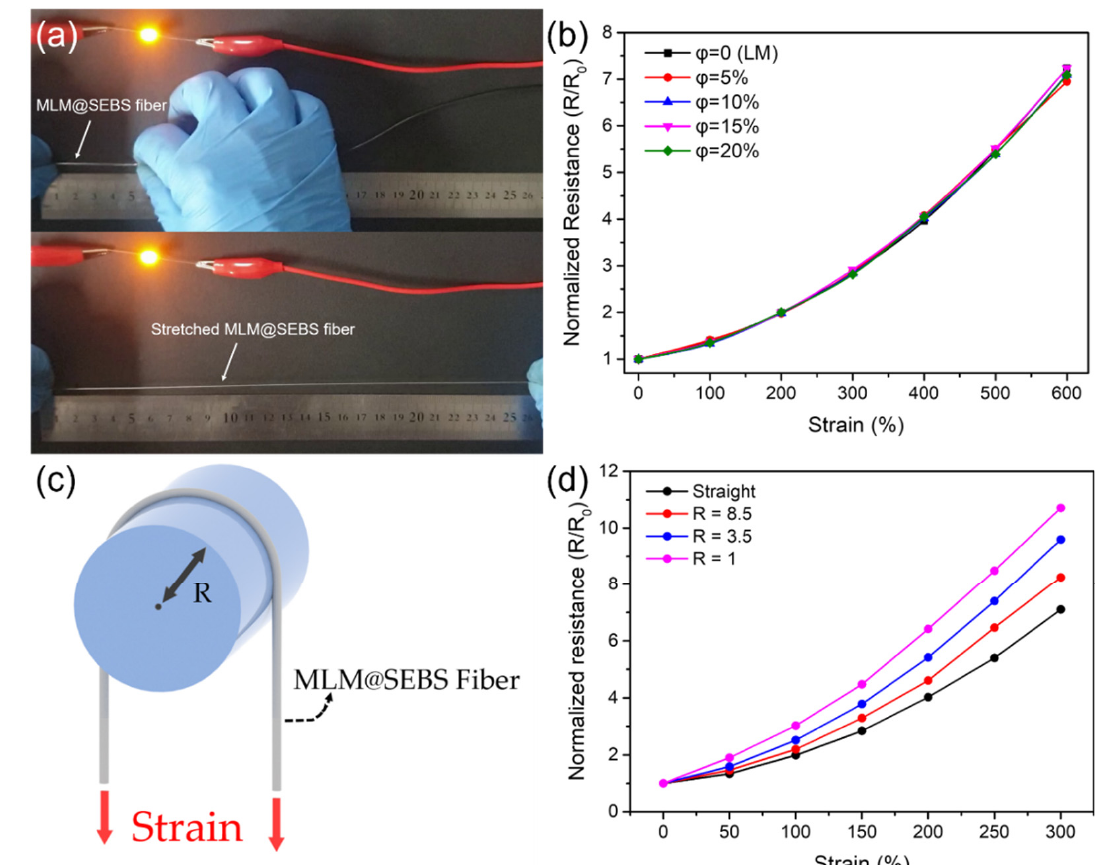
Figure 3. ( a ) A relaxed, 5 cm section of ultrastretchable SEBS fiber with the MLM core with 10 wt% of iron particles in the MLM wire (top), the fiber was stretched to more than 25 cm while maintaining conductivity (bottom). ( b ) The normalized resistance changes of the SEBS fiber with liquid metal core and the MLM core with iron particles with the concentration of 5, 10, 15, and 20 wt% ( φ ) as a function of strain. ( c ) Schematic showing the 180 ◦ bending tensile test. ( d ) The normalized resistance changes of the SEBS fiber with the MLM core with 10 wt% of iron particles in the MLM wire as a function of strain and bending radius (R).